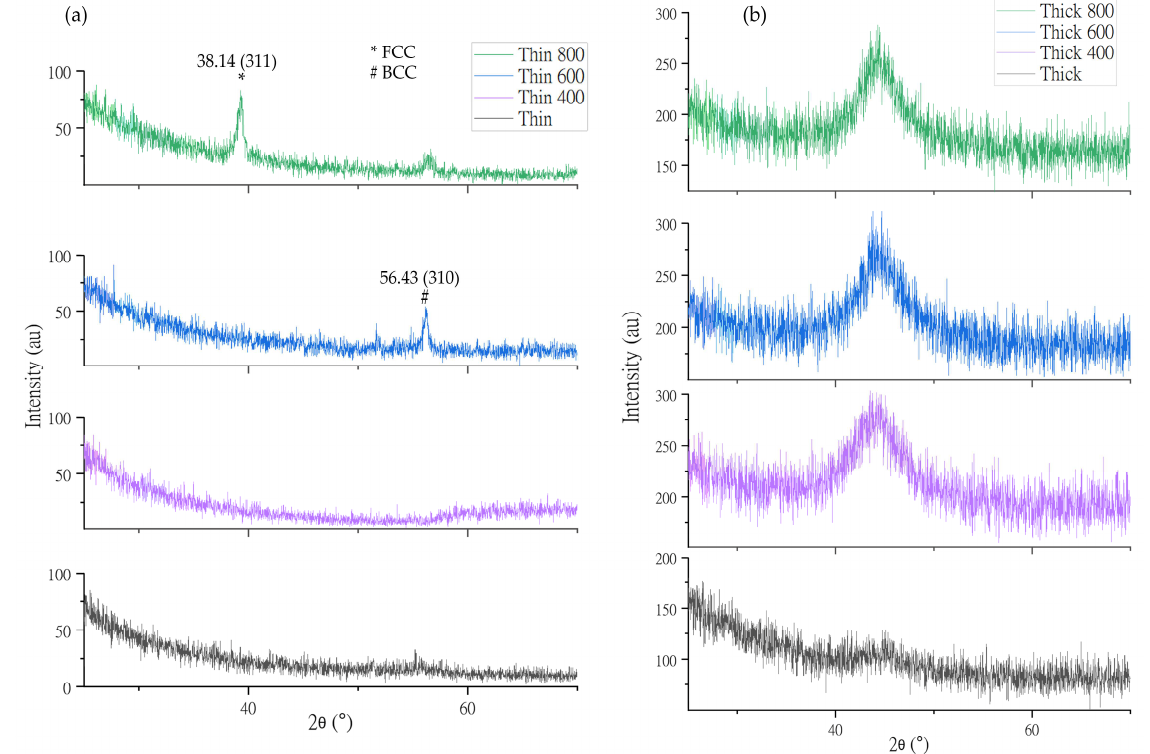
Figure 3. Amorphous XRD peaks of ( a ) thin and ( b ) thick HEA films without heat treatment (WHT) and heat treated at 400 ◦ C, 600 ◦ C, and 800 ◦ C, and heat treated at 400 °C, 600 °C, and 800 °C, respectively.